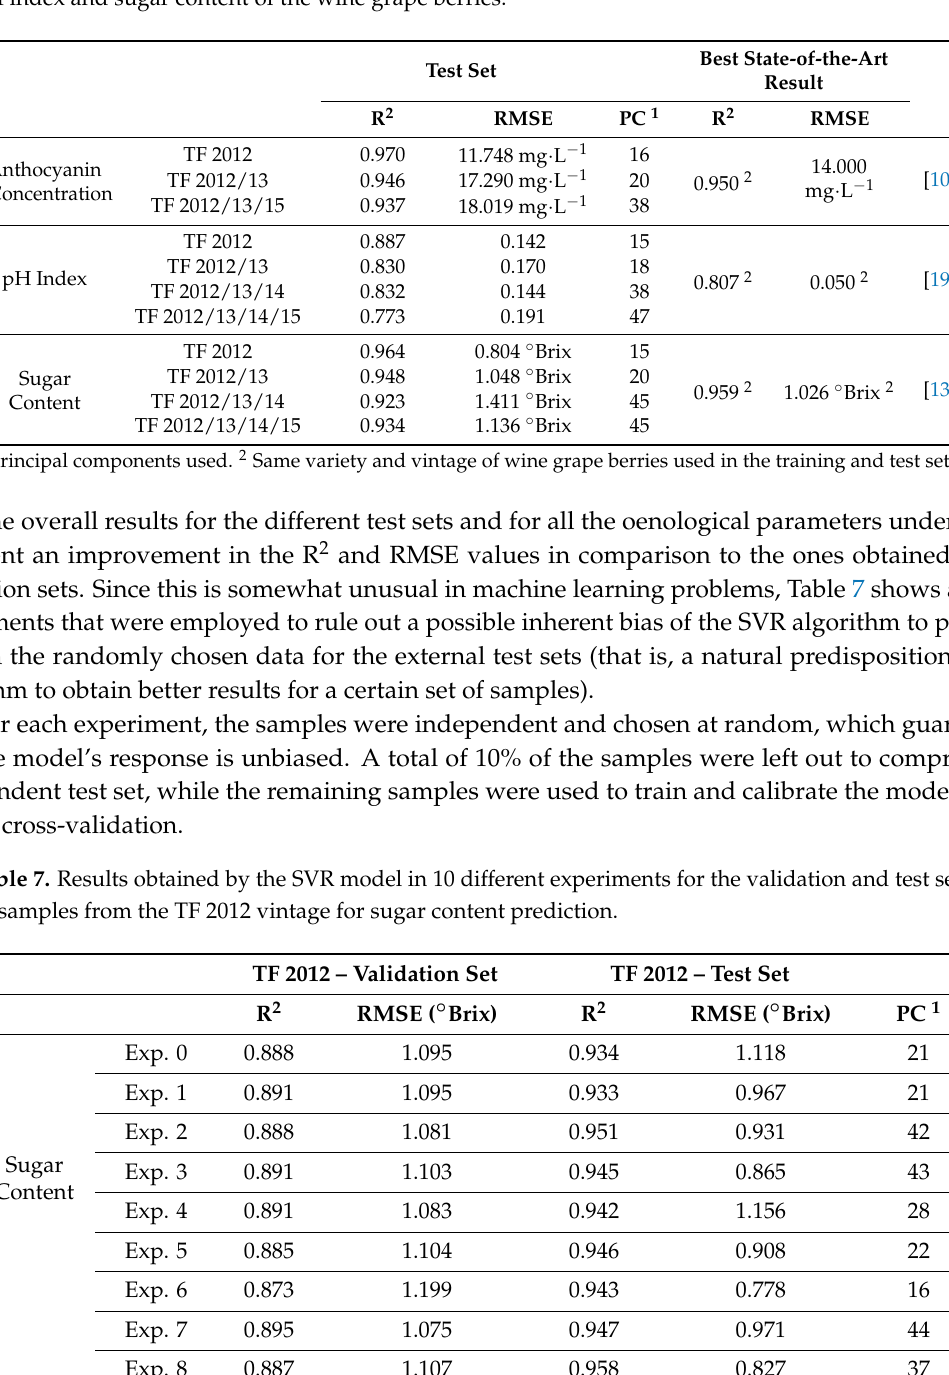
Table 6. Results obtained in the external test set for the determination of the anthocyanin concentration, pH index and sugar content of the wine grape berries.